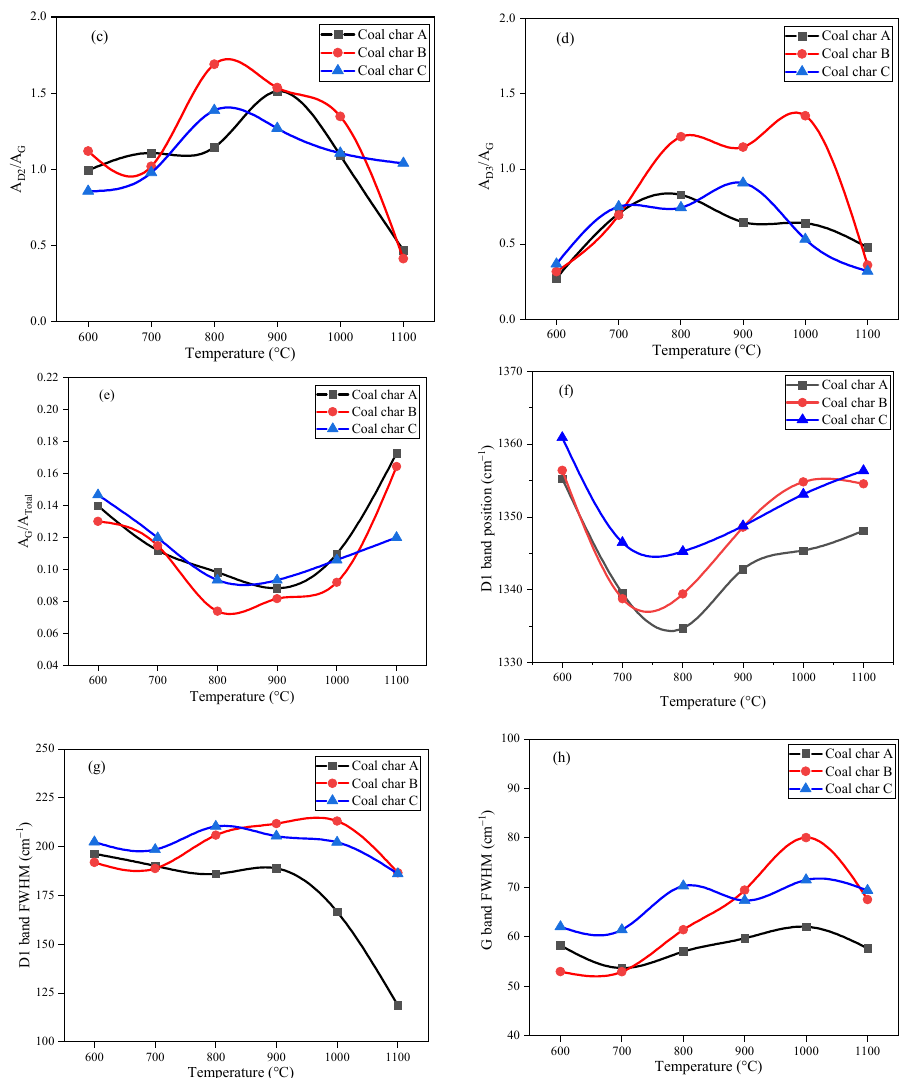
Figure 3. Variations in band parameters with heat treatment temperature of coal chars: ( a ) A Total ; ( b ) A D1 / A G ; ( c ) A D2 / A G ; ( d ) A D3 / A G ; ( e ) A G / A Total ; ( f ) D1 band position; ( g ) D1 band FWHM; ( h ) G band FWHM.